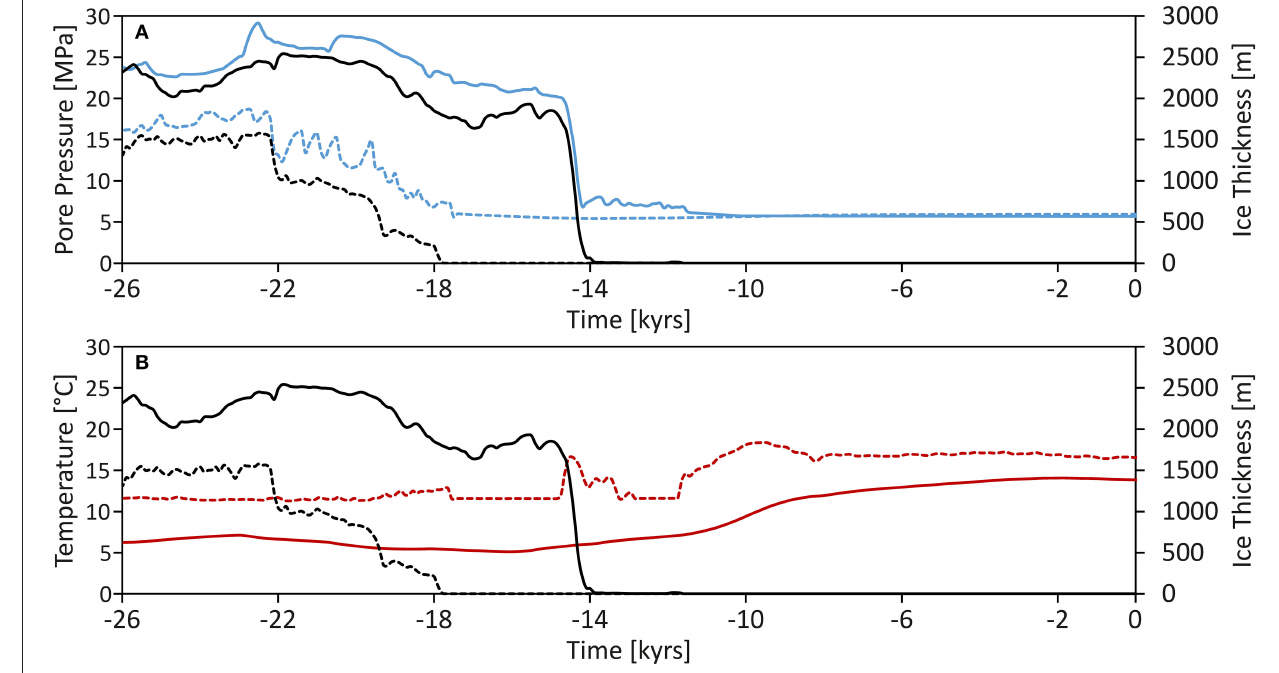
FIGURE 7 | Temporal development of temperature and pressure for representative domains in the model at 500m.b.s.: (A) pore pressure in the central North Sea (stippled blue line), and in Fennoscandian shield domain (solid blue line), (B) temperature in the central North Sea (stippled red line), and in the northern crustal domain (solid red line), (A,B) ice thickness in the central North Sea (stippled black line) and in the northern crustal domain (solid black line). Location of sample points in Figures 4 , 6